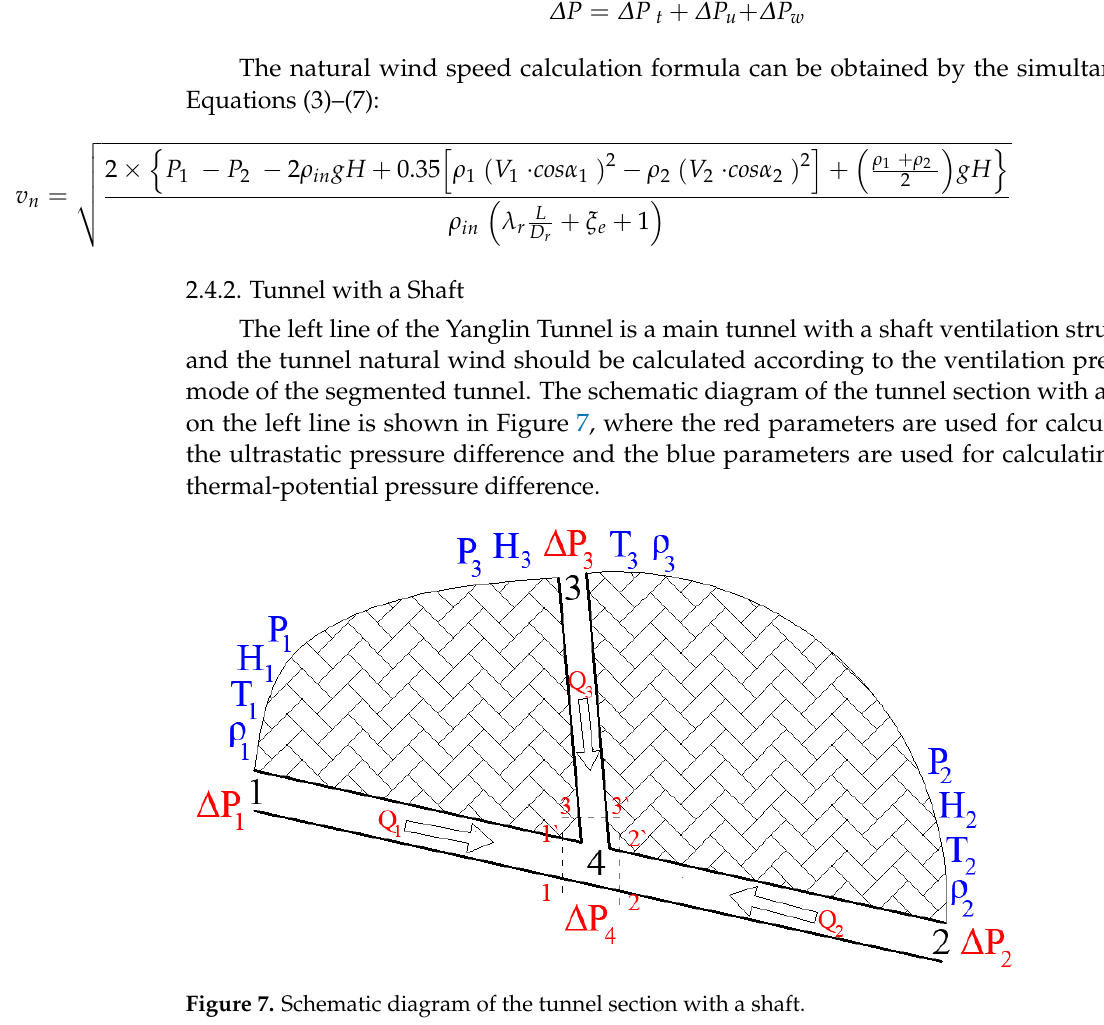
Figure 7. Schematic diagram of the tunnel section with a shaft.